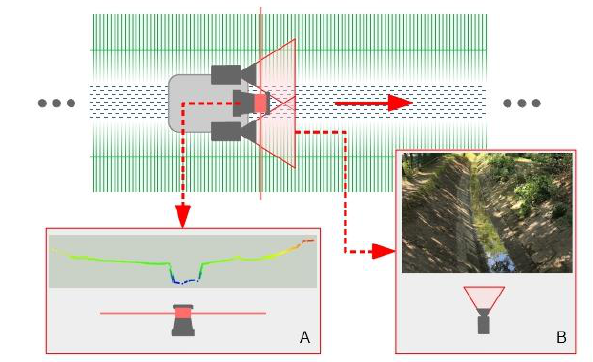
Figure 2 . (on top) Simplified representation of the sensor system. (below) Sample data of the scanner (A) and camera (B).